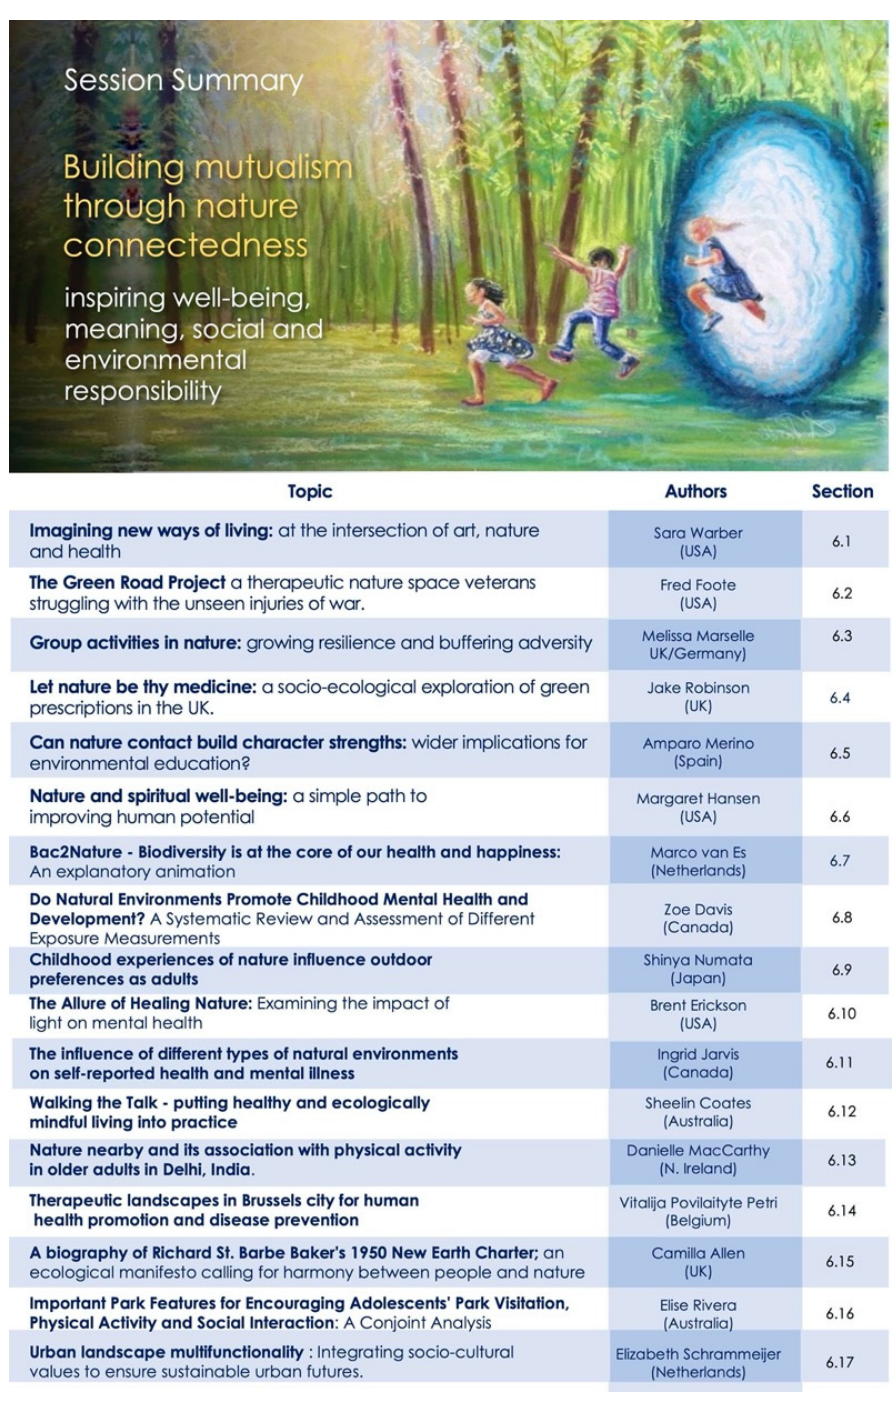
Figure 5. Building mutualism through nature connectedness. Overview of topics and speakers in the session on nature and wellbeing on all scales.